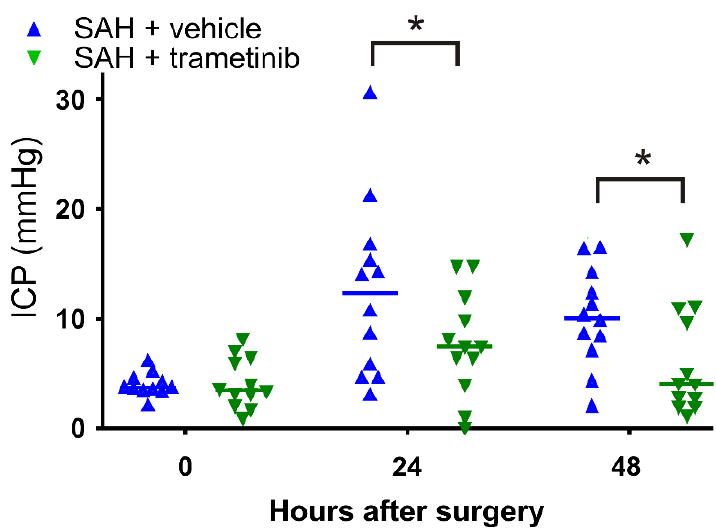
Figure 5. Intracranial pressure post-SAH. The average ICP is significantly higher after 24 h in both groups. The increase in ICP is less in the rats treated with trametinib and, at 48 h, it is only significantly increased in the SAH + vehicle group. A multiple t-test with correction (* p < 0.05) was used for statistical analysis.